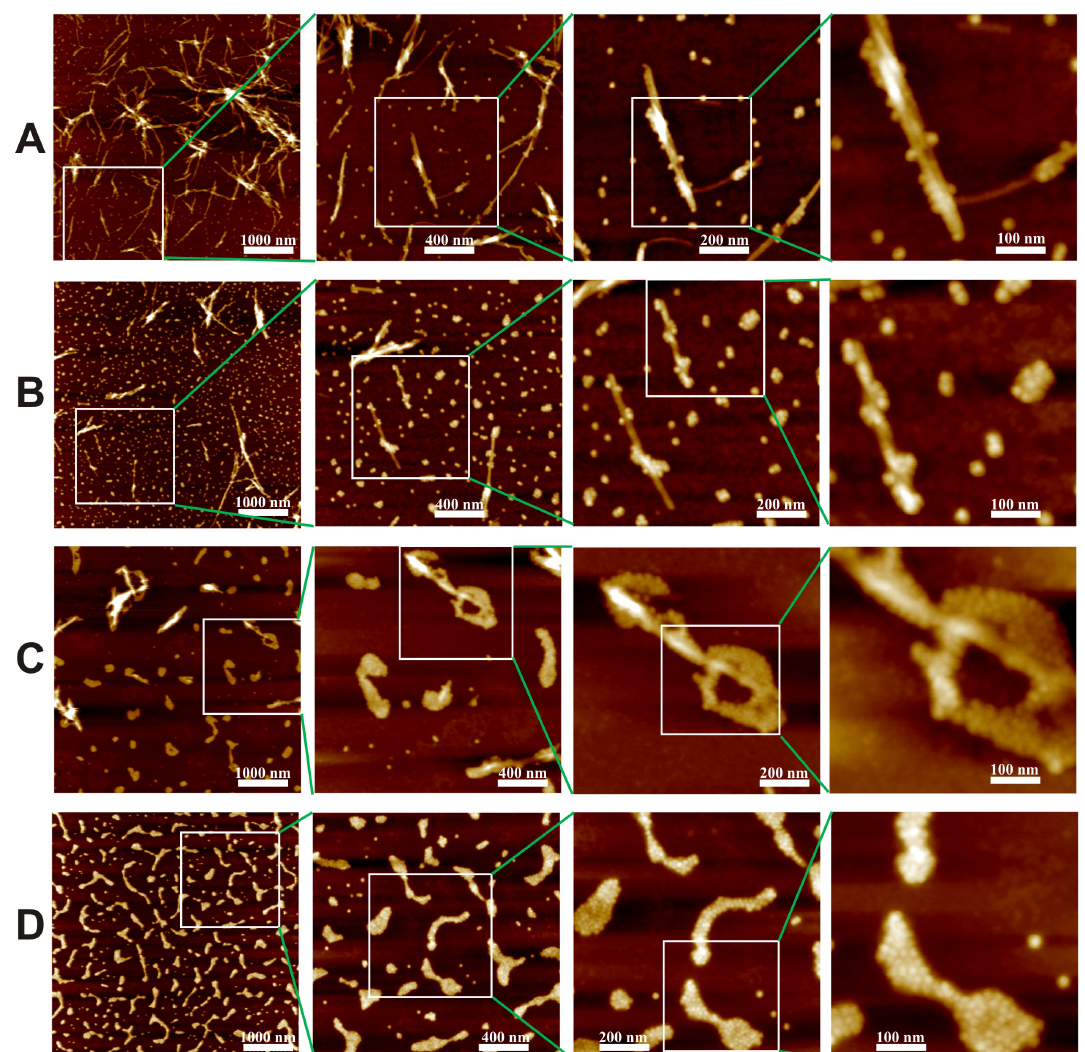
Figure 4. AFM images of the resultant self-assembled LAF incorporated with an array of volume concentration of 10 nm NPs, ( A ) 10 µ L, ( B ) 15 µ L, ( C ) 20 µ L and ( D ) 30 µ L at increasing scales of resolution from left to right is illustrated, and each zoomed-in is enclosed by a white rectangle from the preceding image of lower